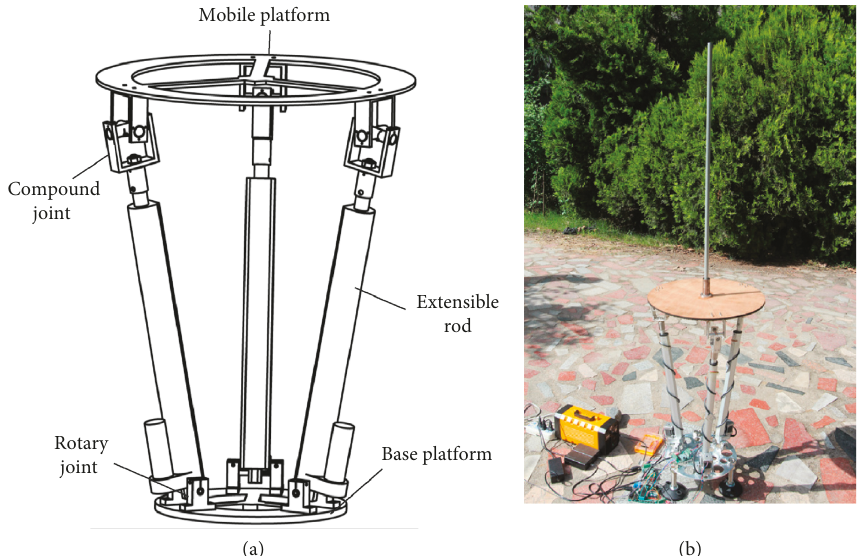
Figure 5: Structure of the TER pointing mechanism: (a) diagram; (b) physical model.